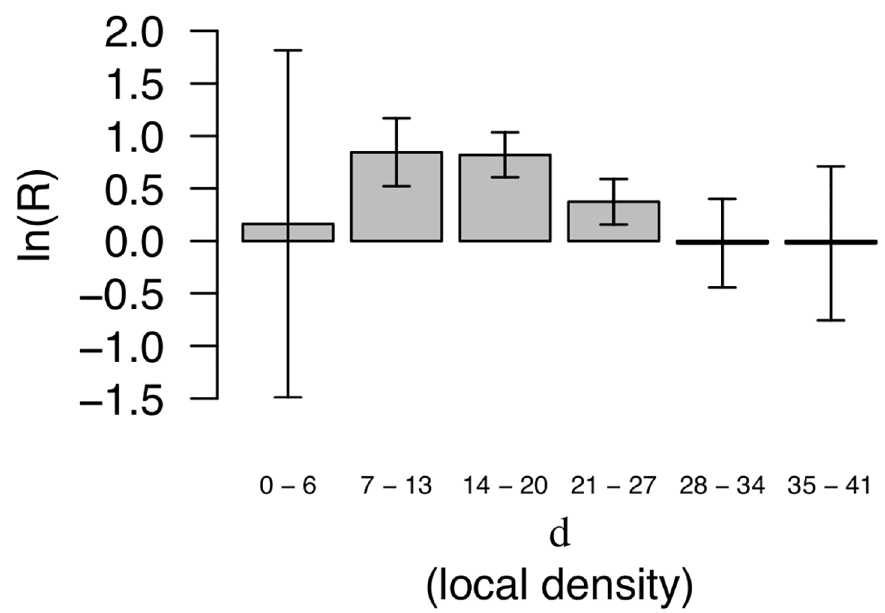
Fig 3. On peripheral proteins (‘Peripheral’ dataset) protrusions in low density regions are more often hydrophobes compared to the ‘Non-binding surfaces’. The plot shows the logarithm of the odds-ratio (Eq 10) comparing the frequency of hydrophobes on ‘vertex residues’ in peripheral proteins and non-binding surfaces. Positive values reflect higher frequencies in the peripheral proteins. The horizontal axis shows the protein density d around the protrusion, measured as the number of C α and C β atoms within 1 nm . Vertex residues are all on the convex hull, but only the vertex residues with d < 22 are protrusions. The leftmost bar with d < 7 corresponds mostly to chain terminals. More precisely, the vertical axis shows R ð A ; B ; ^ F Þ where A denotes the dataset ‘Peripheral’, hydrophobe j vertex \ l < d (cid:20) u B the ‘Non-binding surfaces’, l and u denote the lower and upper limits of the ranges given on the vertical axis, and d is the local protein density defined in ‘Materials and methods’. Error bars are 95% confidence intervals.